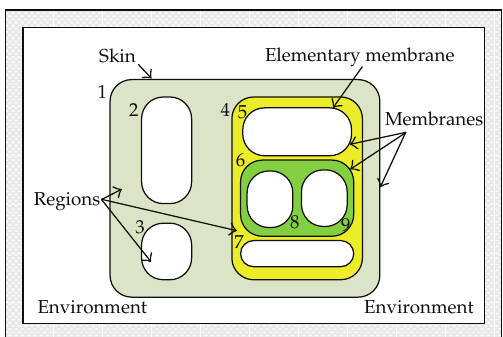
Figure 3: Traditional membrane